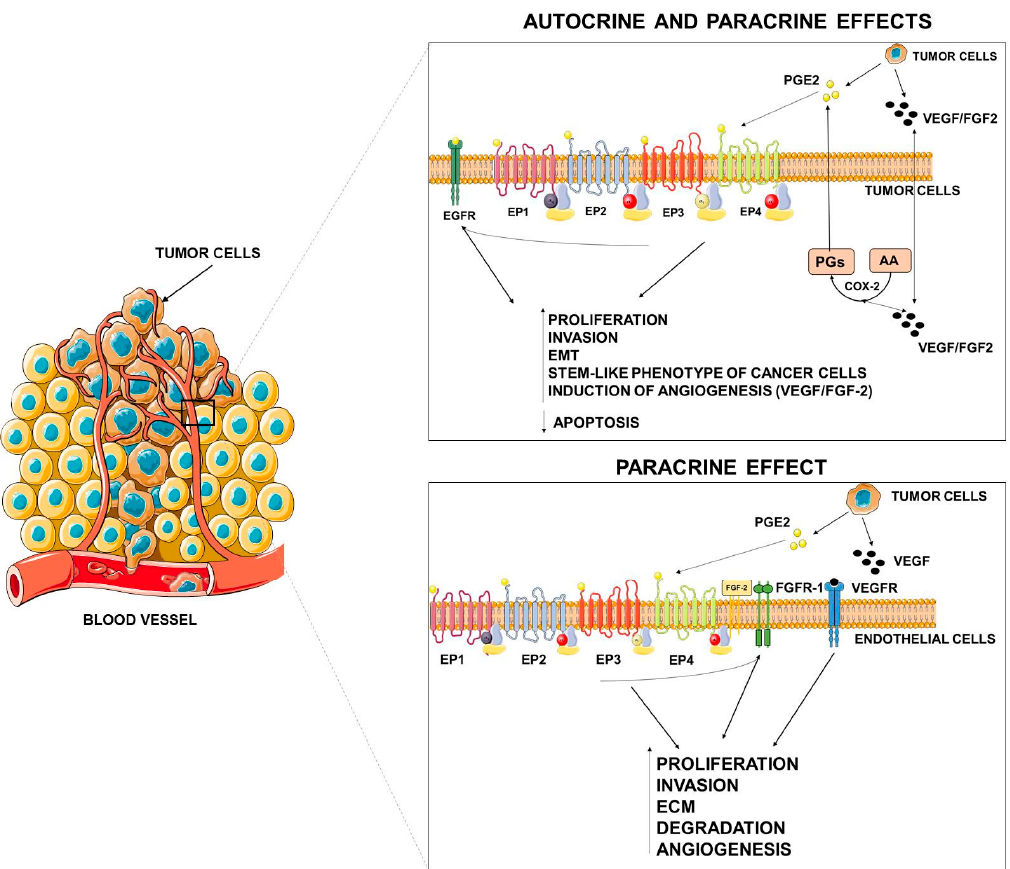
Figure 2. Autocrine and paracrine effects of PGE2. PGE2, released by tumor cells, may elicit autocrine and paracrine effects on tumor or stromal cells either by specific activation of its receptors or by tyrosine kinase (TK) receptor transactivation. VEGF = vascular endothelial growth factor, FGF = fibroblast growth factor, EMT = epithelial mesenchymal transition, ECM = extracellular matrix. This figure was 3.0 Unported License; https: //